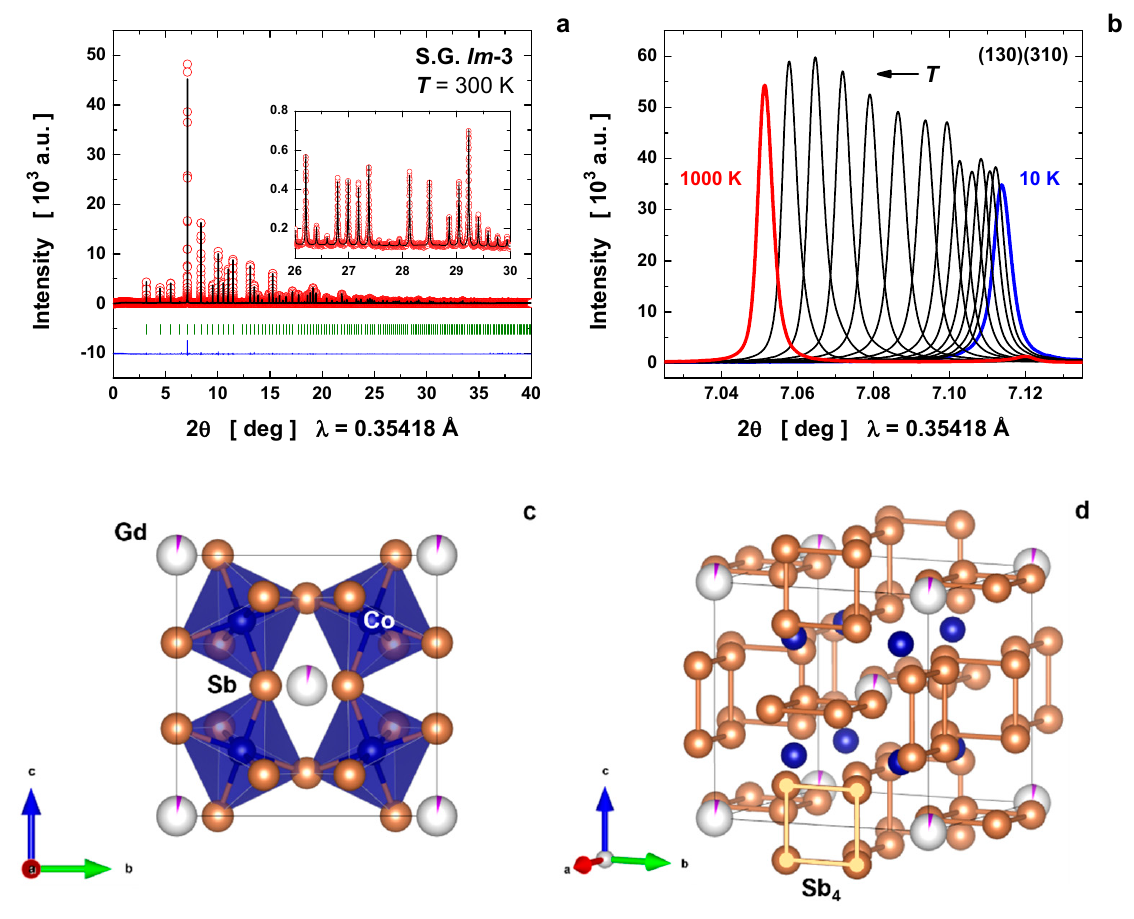
Figure 1. ( a ) Rietveld refinement of the synchrotron X-ray-diffraction pattern of Gd-filled Co 4 Sb 12 skutterudite at room temperature. ( b ) Temperature evolution in the range 10–1000 K of the main reflection (130)(310). In part ( a ), red open circles are the experimental data, black line denotes the calculated profile, blue line the difference between experimental and calculated data, and dark green bars the Bragg reflections. Crystal-structure representation exhibiting ( c ) the octahedral units (CoSb 6 ) and ( d ) the Sb rings (Sb 4 ). Table 1. Refined structural parameters of the Gd-filled Co 4 Sb 12 skutterudite from SXRD data at room temperature. Abbreviations : U eq is the equivalent mean-square displacement, Site Occ. the site occupancy, and ρ t the theoretical